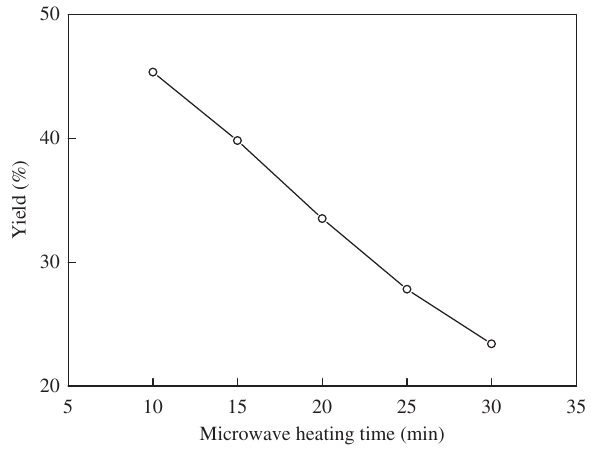
Figure 9: SEM image of activated